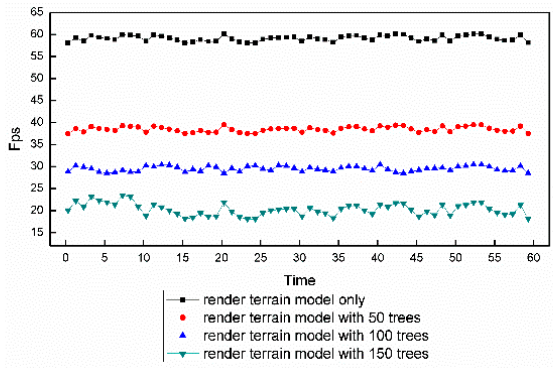
Figure 18. Frame rates for rendering a grove at a resolution of 1024 × 576.